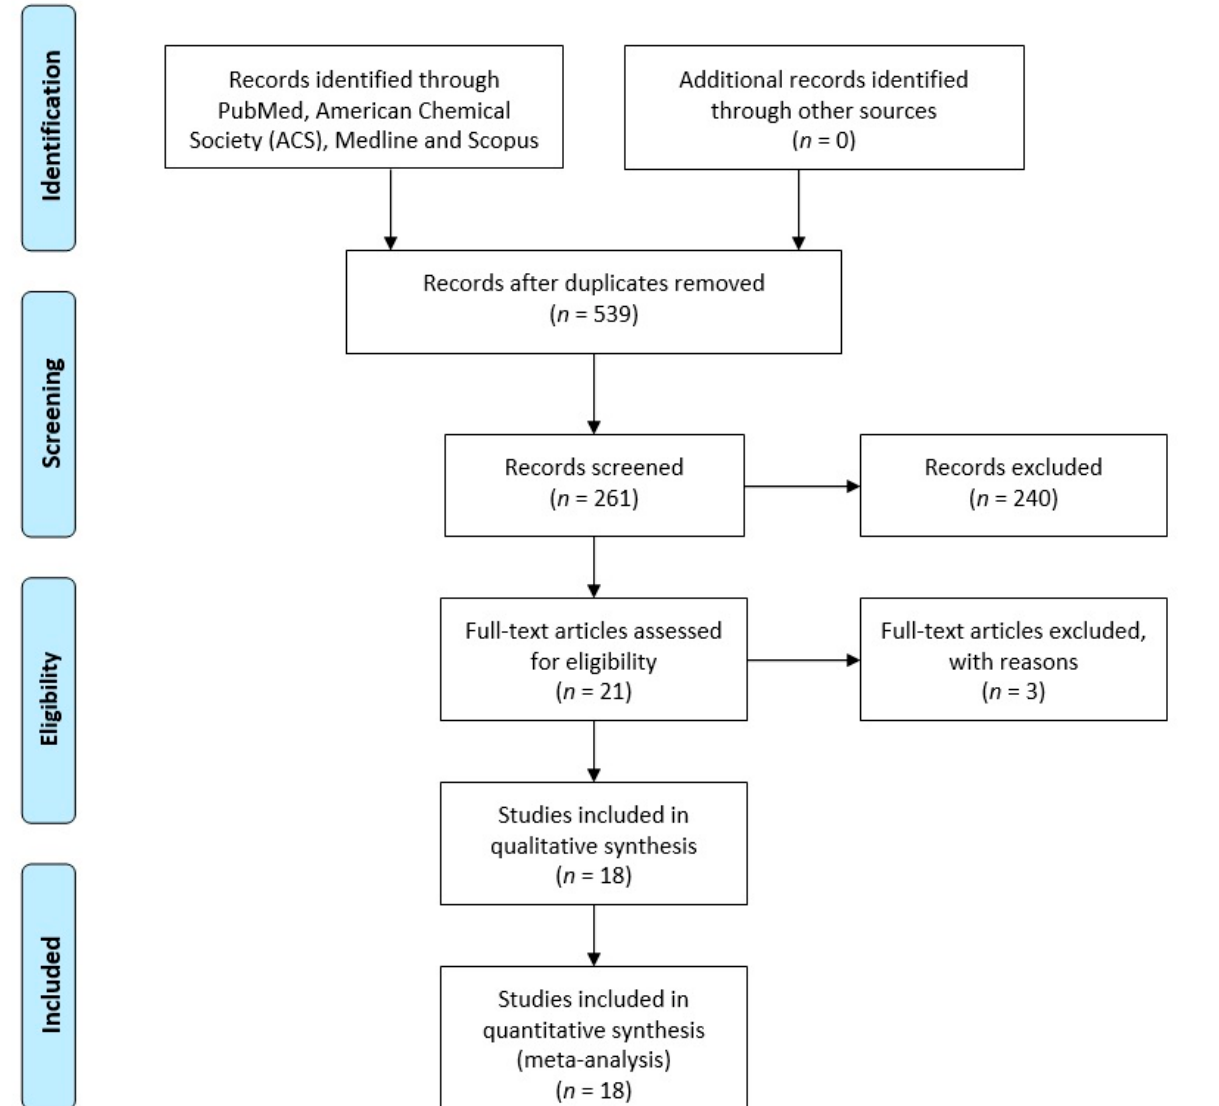
Figure 1. PRISMA (Preferred Reporting Items for Systematic Reviews and Meta-Analyses) 2009 flow diagram [30]. Selection of studies.